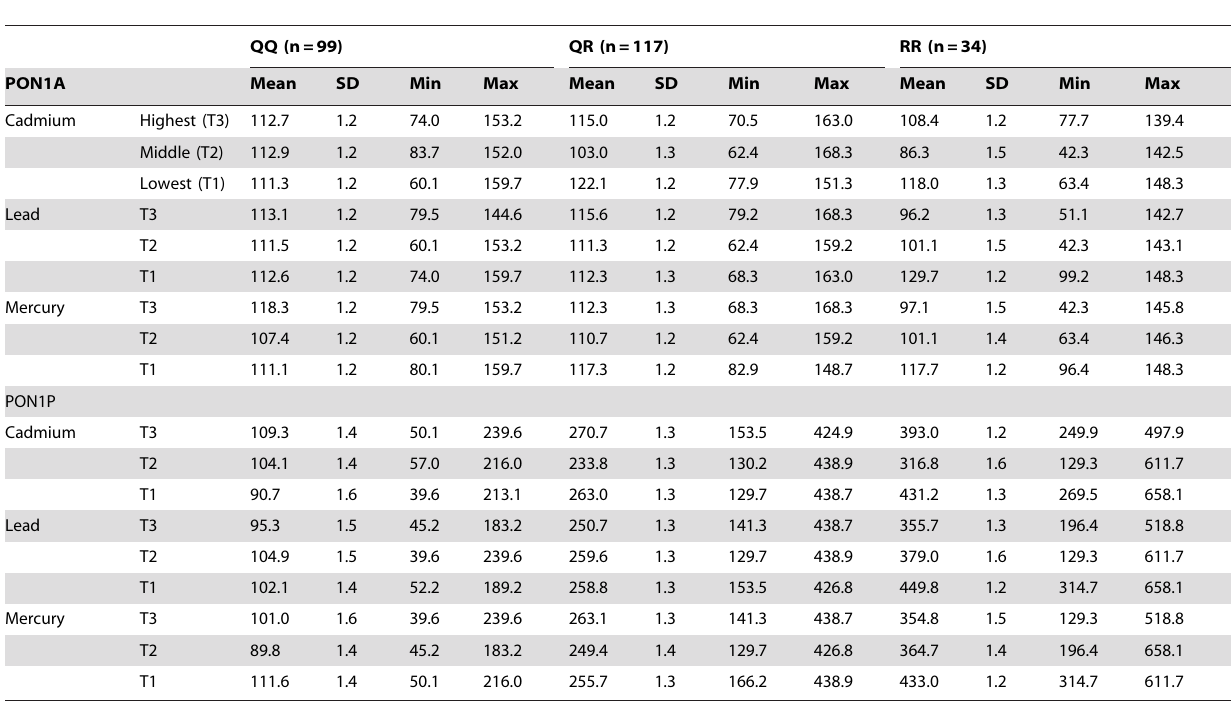
Table 2. Geometric mean of PON1A and PON1P levels by metal tertile and genotype, in the BioCycle Study (N= 250), Buffalo, NY (2005–2007).